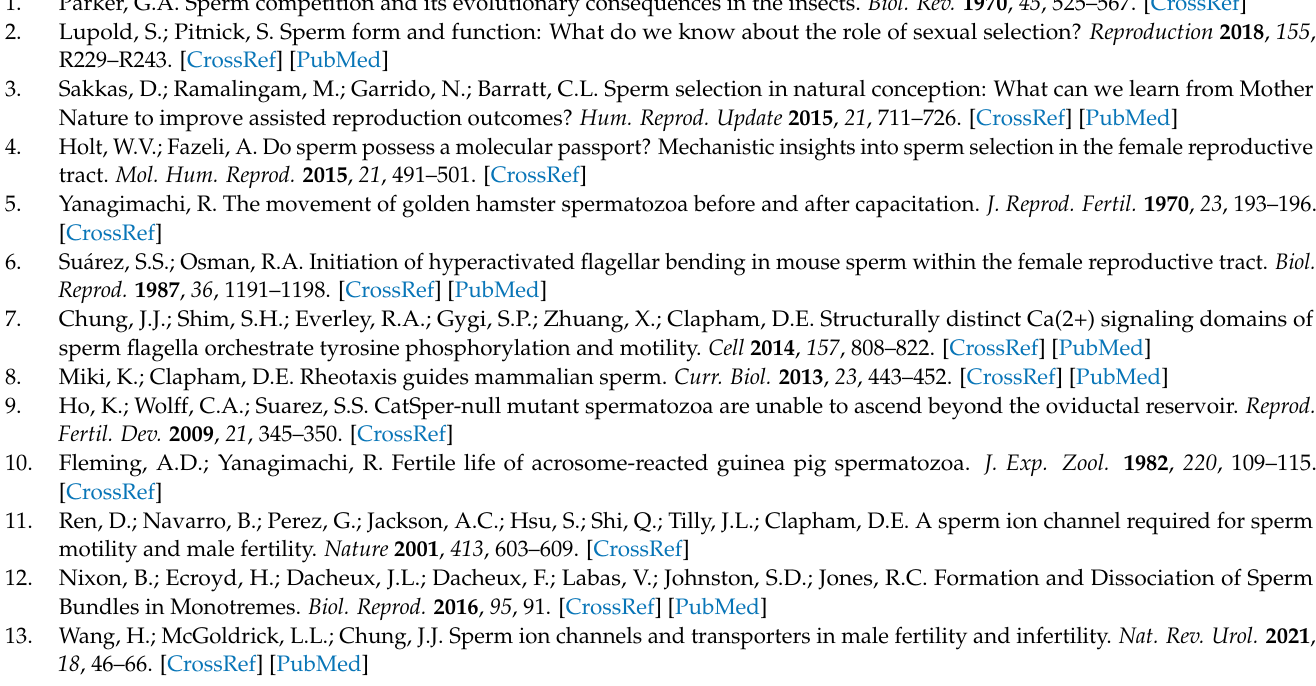
sperm cells, Figure S4: CatSper ζ orthologs are conserved in marsupials, Table S1: Species and CatSper orthologs information for sequence analyses, Table S2: Primer pairs for qRT-PCR used in this